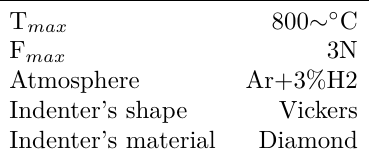
Table 1. Characteristics of high temperature